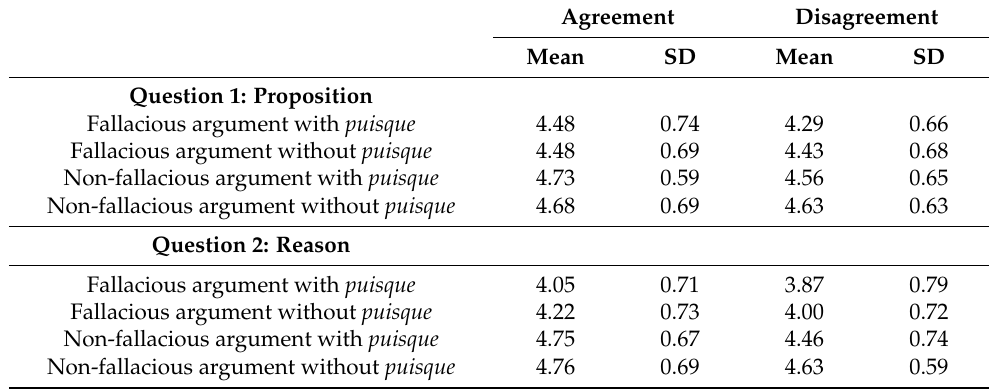
Table 1. Means and SD of the perceived agreement/disagreement between the